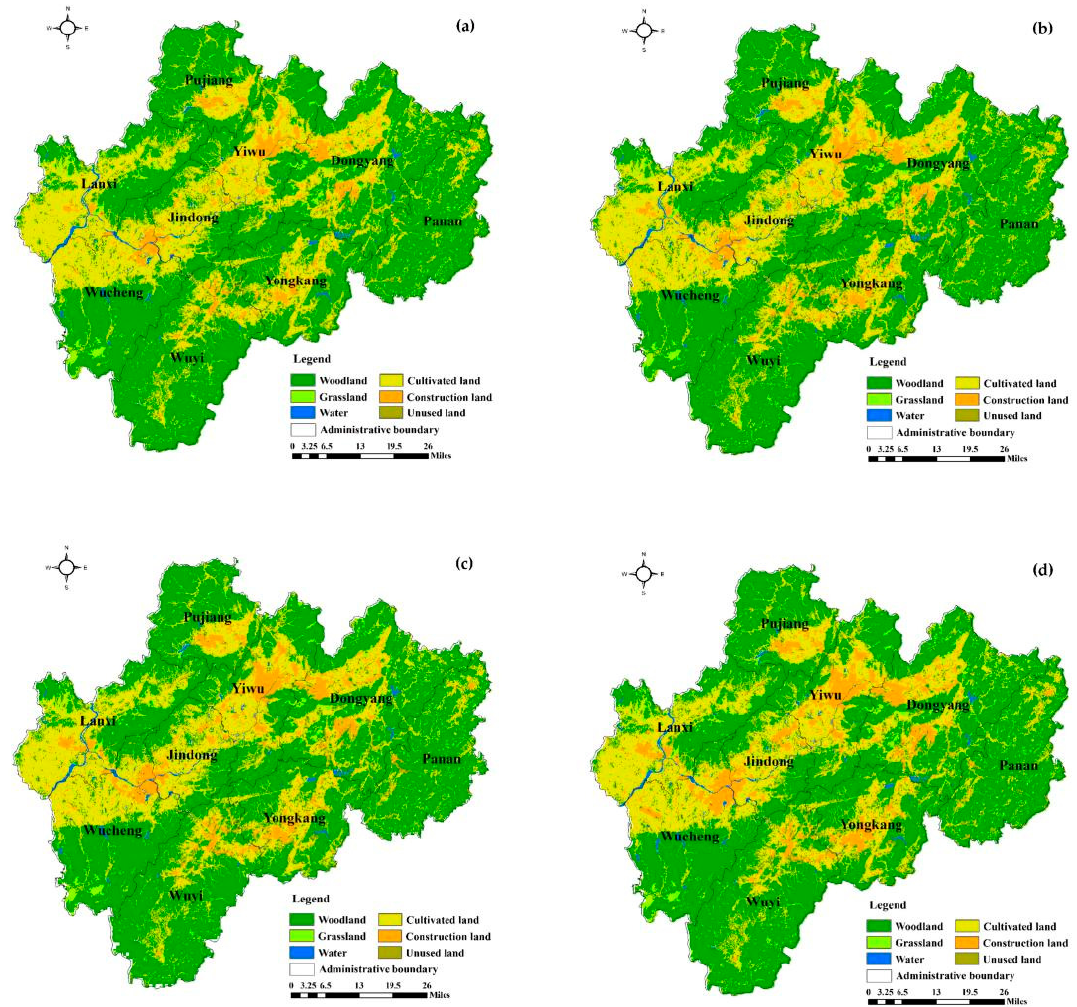
Figure 3. Spatial distribution of Jinhua land-use ( a ) 2005; ( b ) 2010; ( c ) 2015; ( d ) 2018. Table 3. Land-use transfer matrix for 2005–2010 ( km 2 ).